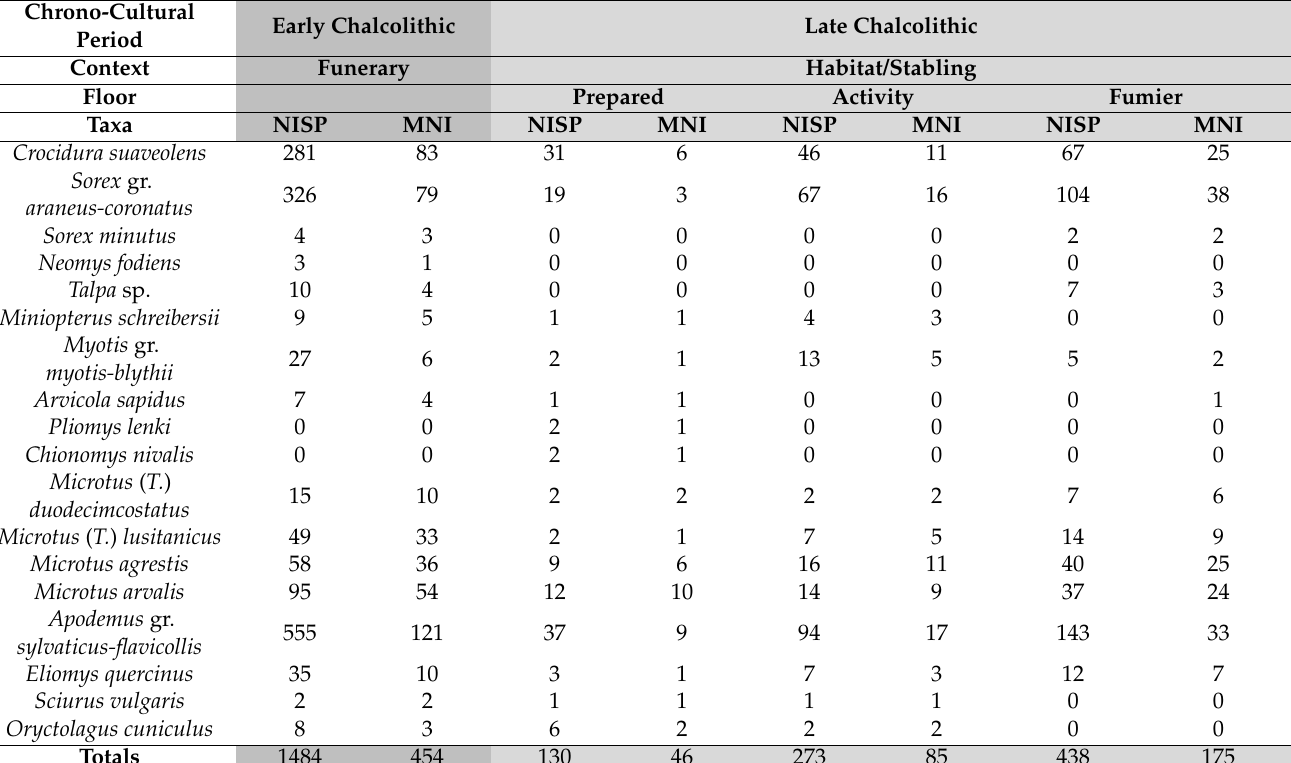
Table 3. Number of identified specimens (NISP) and minimal number of individuals (MNI) for the Chalcolithic levels of El Portal ó n de Cueva